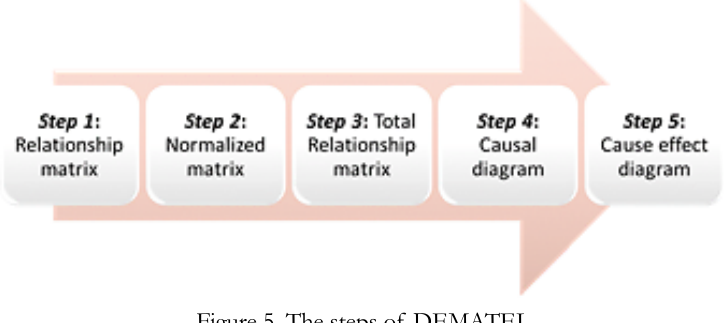
Figure 5. The steps of